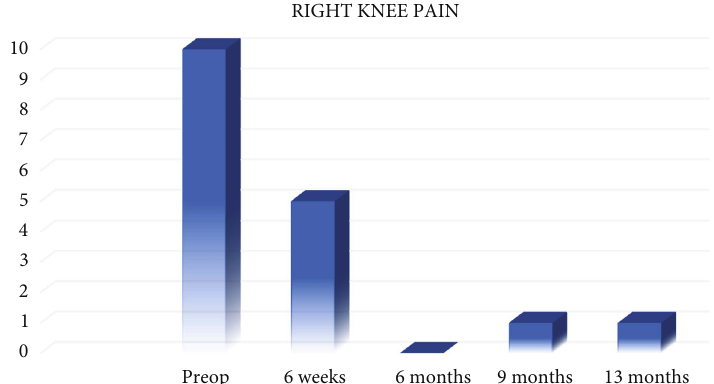
Figure 14: Right knee pain